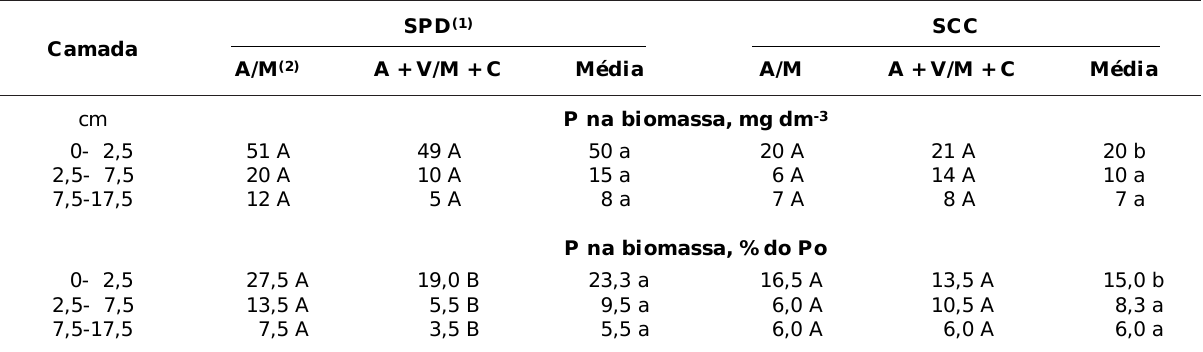
(1) SPD = sistema plantio direto; SCC = sistema de cultivo convencional. (2) A/M = aveia preta / milho; A + V/M + C = aveia preta + ervilhaca / milho + caupi. Médias, na linha, seguidas pela mesma letra maiúscula, para sucessões de culturas, e minúscula, para métodos de preparo do solo, não diferem pelo teste de Tukey (p < 0,05).